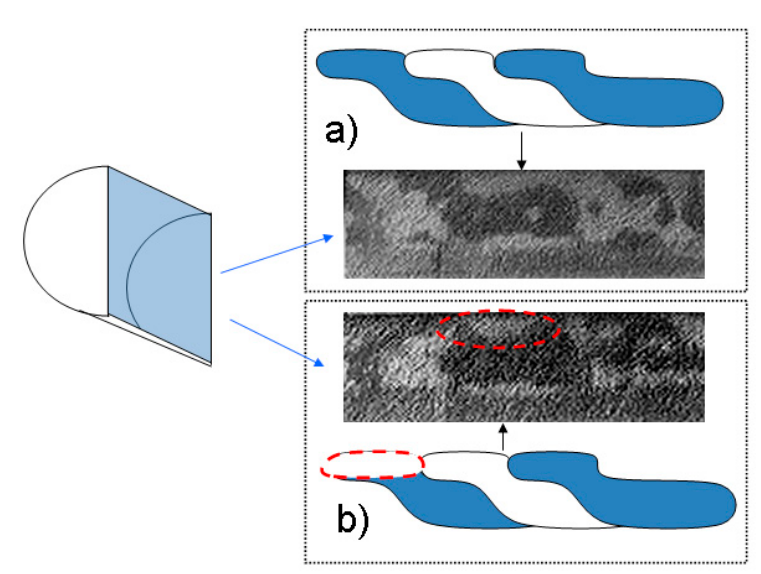
Figure 7. Domain structure in the surface of half-tube shaped microwire. ( a ) H AX = 0.8 Oe, ( b ) H AX = 0.4 Oe. ( b ) H AX = 0.4